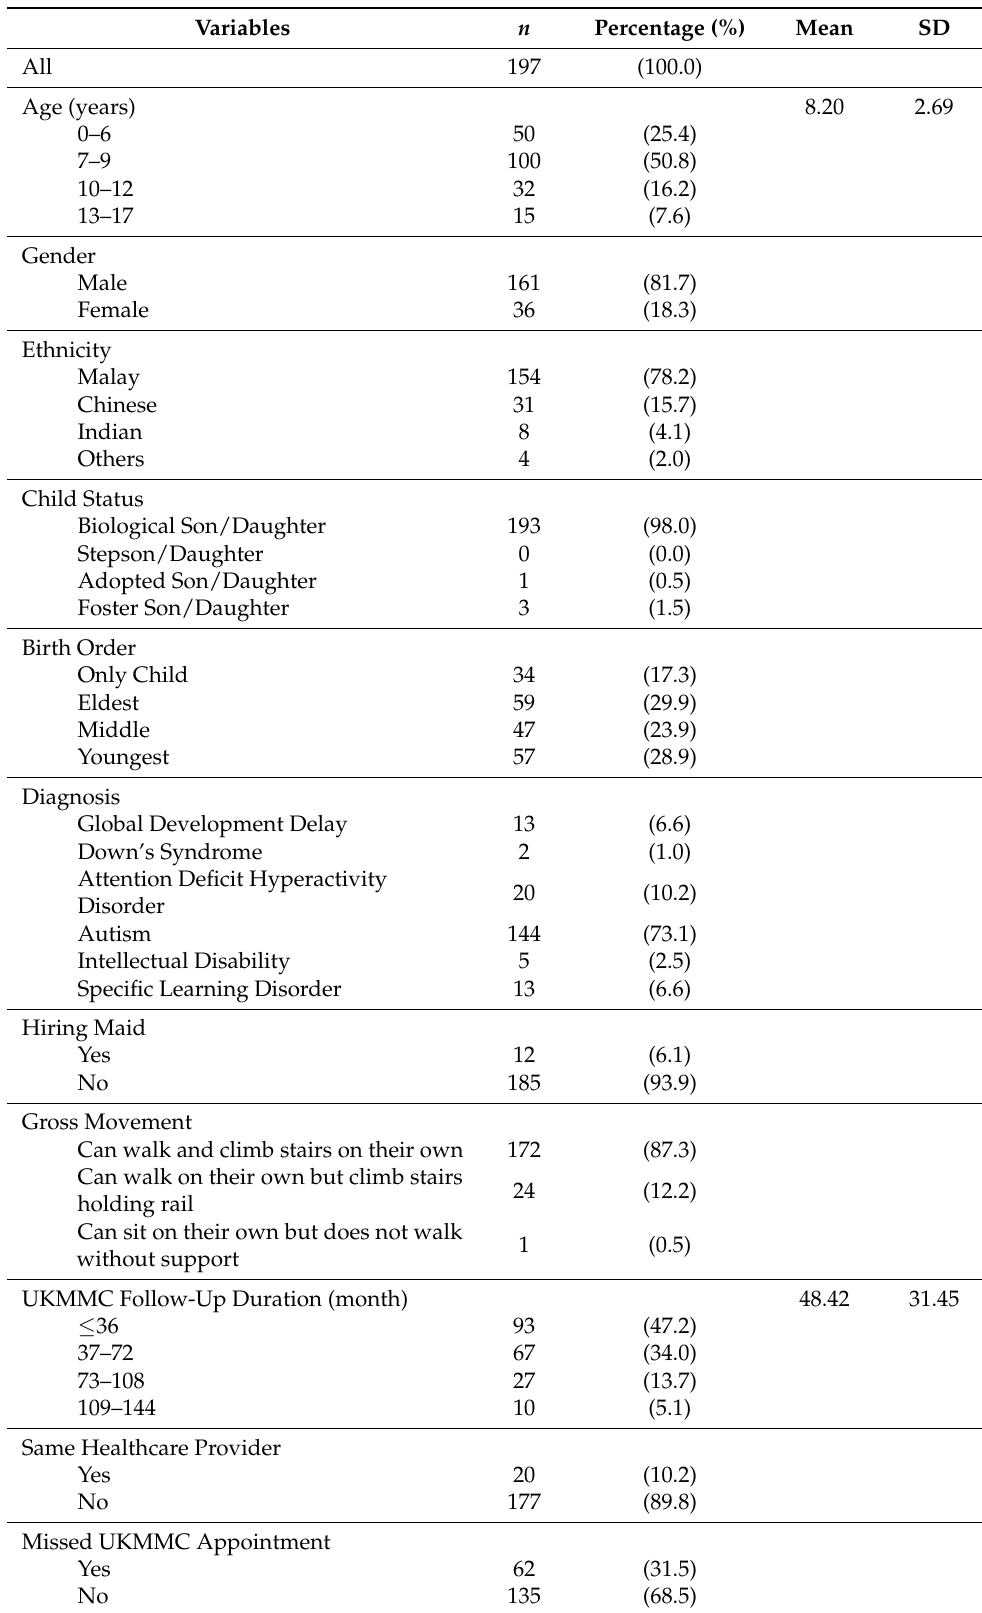
Table 3. Sociodemographic and characteristics of children with developmental disabilities ( n =